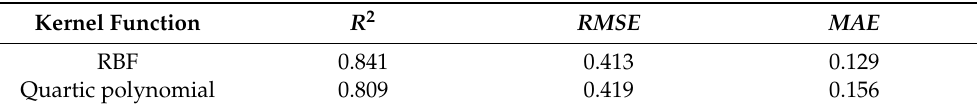
Figure 6. Comparison between predicted results and experimental data of the gas permeability by SVR method. Table 4. Statistical indicators of the results calculated by SVR analytical models.